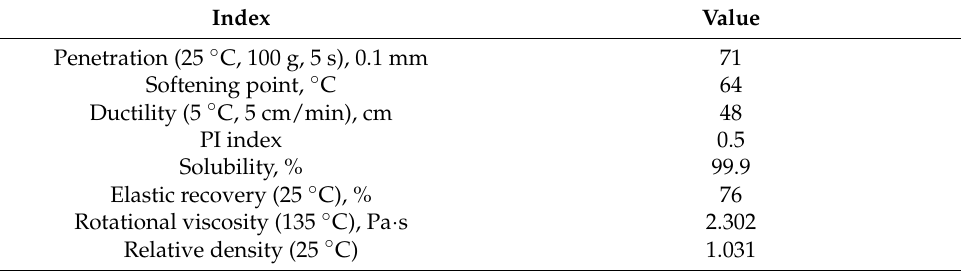
Table 1. Test results of performance of the SBS-modified asphalt.